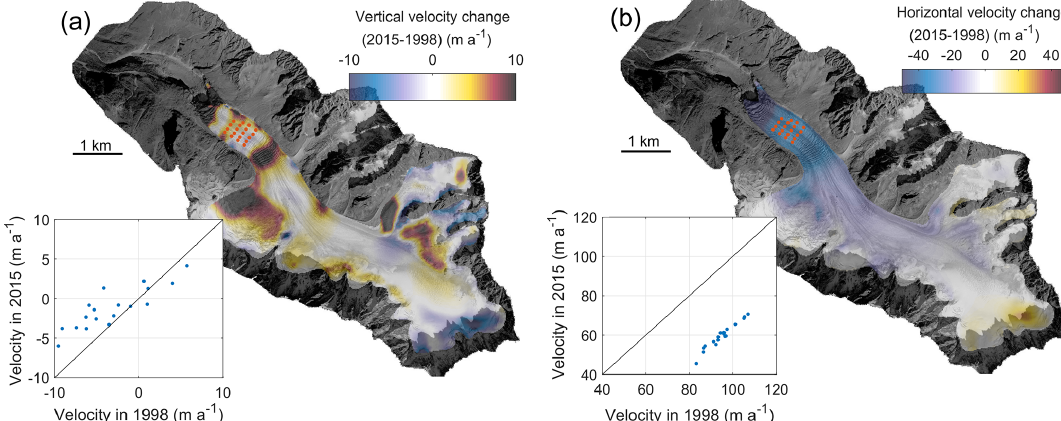
Figure 14. Modelled changes in vertical (a) and horizontal (b) surface velocities between 1998 and 2015. Insets compare modelled velocities at the stake location (orange dots) between 1998 and